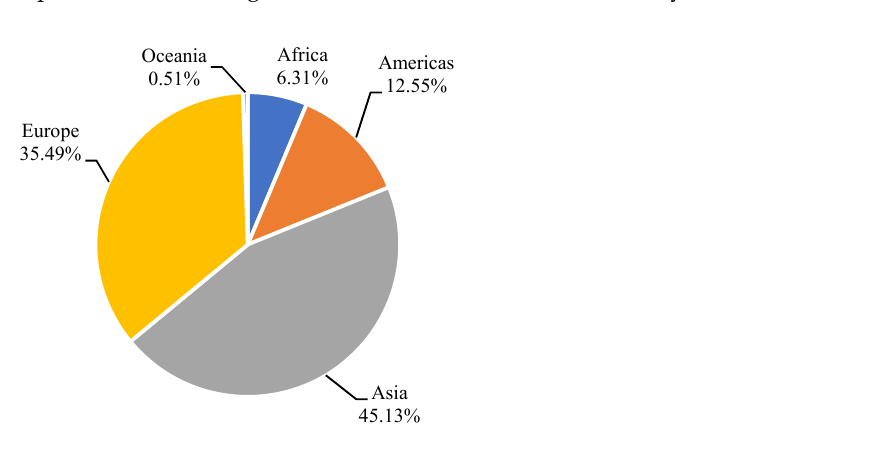
Figure 3. Global production share of potatoes in different continents during 2000–2019. Date from reference [12]. Copyright 2021 FAO. Table 1. Yields of potato in different continents. Date from ref. [12]. Copyright 2021 FAO.